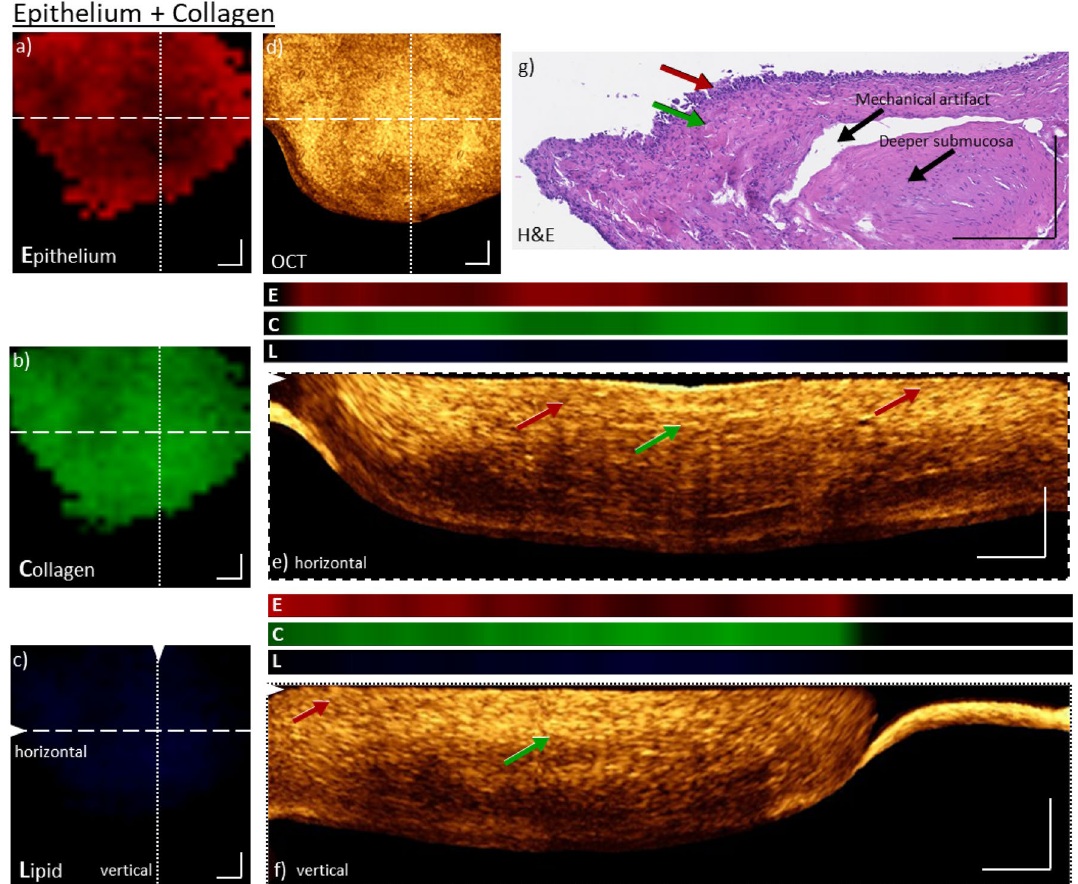
Figure 3. Co-registered, morpho-molecular information of OCT and Raman maps on a bladder biopsy with mixed epithelium and collagen signals. Enface Raman map indicates homogeneous distribution of epithelial ( a ) and collagen ( b ) signals, but no significant lipid contributions ( c ). The collagen signals are reduced in locations where the epithelial signal is increased and vice versa. For comparison, the enface OCT maximum intensity projection of ten slices from a depth of 90–120 µm is shown ( d ). The higher signal intensity in the OCT correlates quite well with the higher intensity in collagen signal ( b ). While a reduced intensity correlates better with the increase of epithelium tissue. The maximum intensity projections of ten cross-sectional OCT B-scans, from positions indicated by dashed and dotted lines in the images, are plotted in ( e , f ). The co-registered molecular Raman information (E: Epithelium, C: Collagen, L: Lipid) is plotted above, and shows a good overlap between the signals, i.e. brighter OCT signal overlapping with the collagen signals, while the darker areas correlate to the epithelial signals. For comparison, H&E image ( g ) of the same biopsy shows both collagen and epithelium regions, indicated by red and green arrows corresponding to epithelium and collagen Raman signals respectively. The epithelium is indicated with a red arrow. The green arrow is indicating the lamina propria with high collagen content. A mechanical artifact and the deeper lamina propria layer of the bladder wall are additionally visible. Scale bars: 250